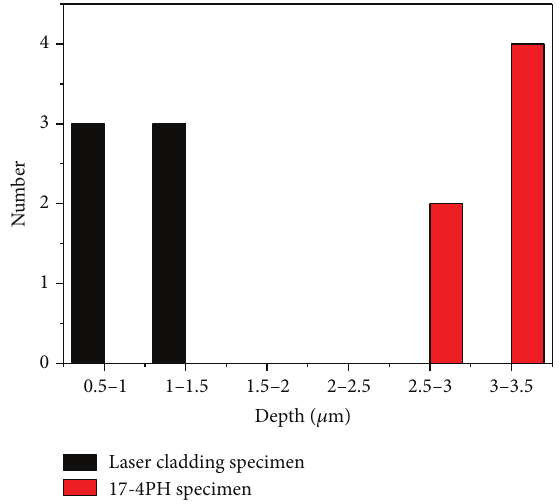
Figure 19: Frequency distribution diagram of impact